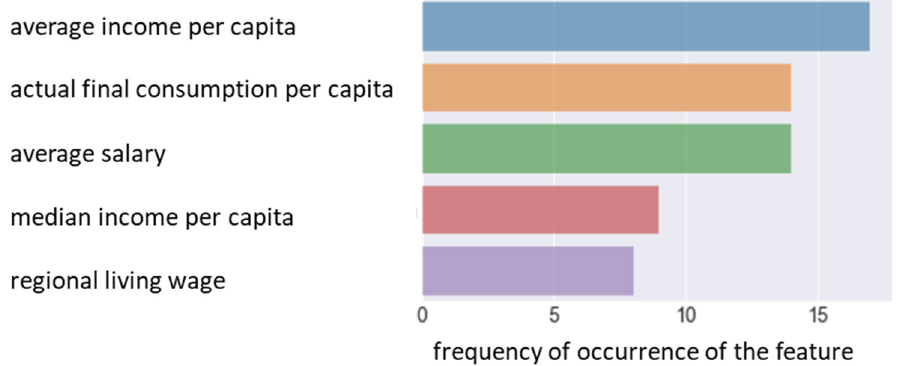
Figure 3. TOP 5 most common factors in the Volga Federal District.